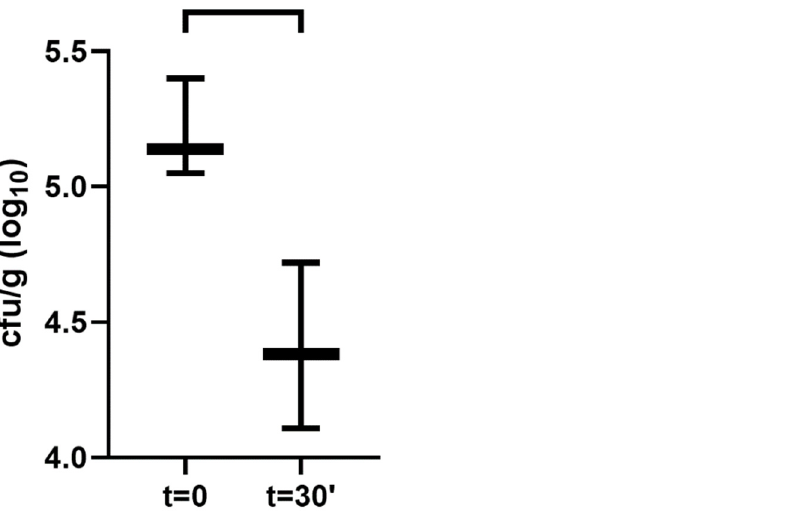
Figure 1. The reduction in viable rate of bacteria during ceviche preparation, *— p = 0.0182.